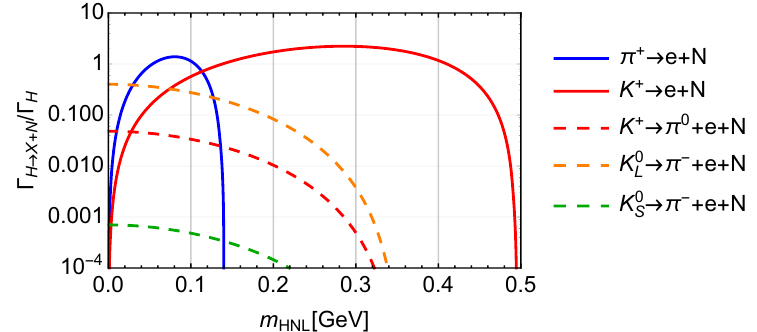
Figure 3 . Light mesons decay width to HNLs related to the measured value of the total decay width for pions and kaons correspondingly. In this (cid:12)gure we take U e = 1, U (cid:22) = U (cid:28) = 0. The ratio for two-body decay channels exceeds 1 due to the helicity enhancement when a massive HNL is present in the (cid:12)nal state instead of